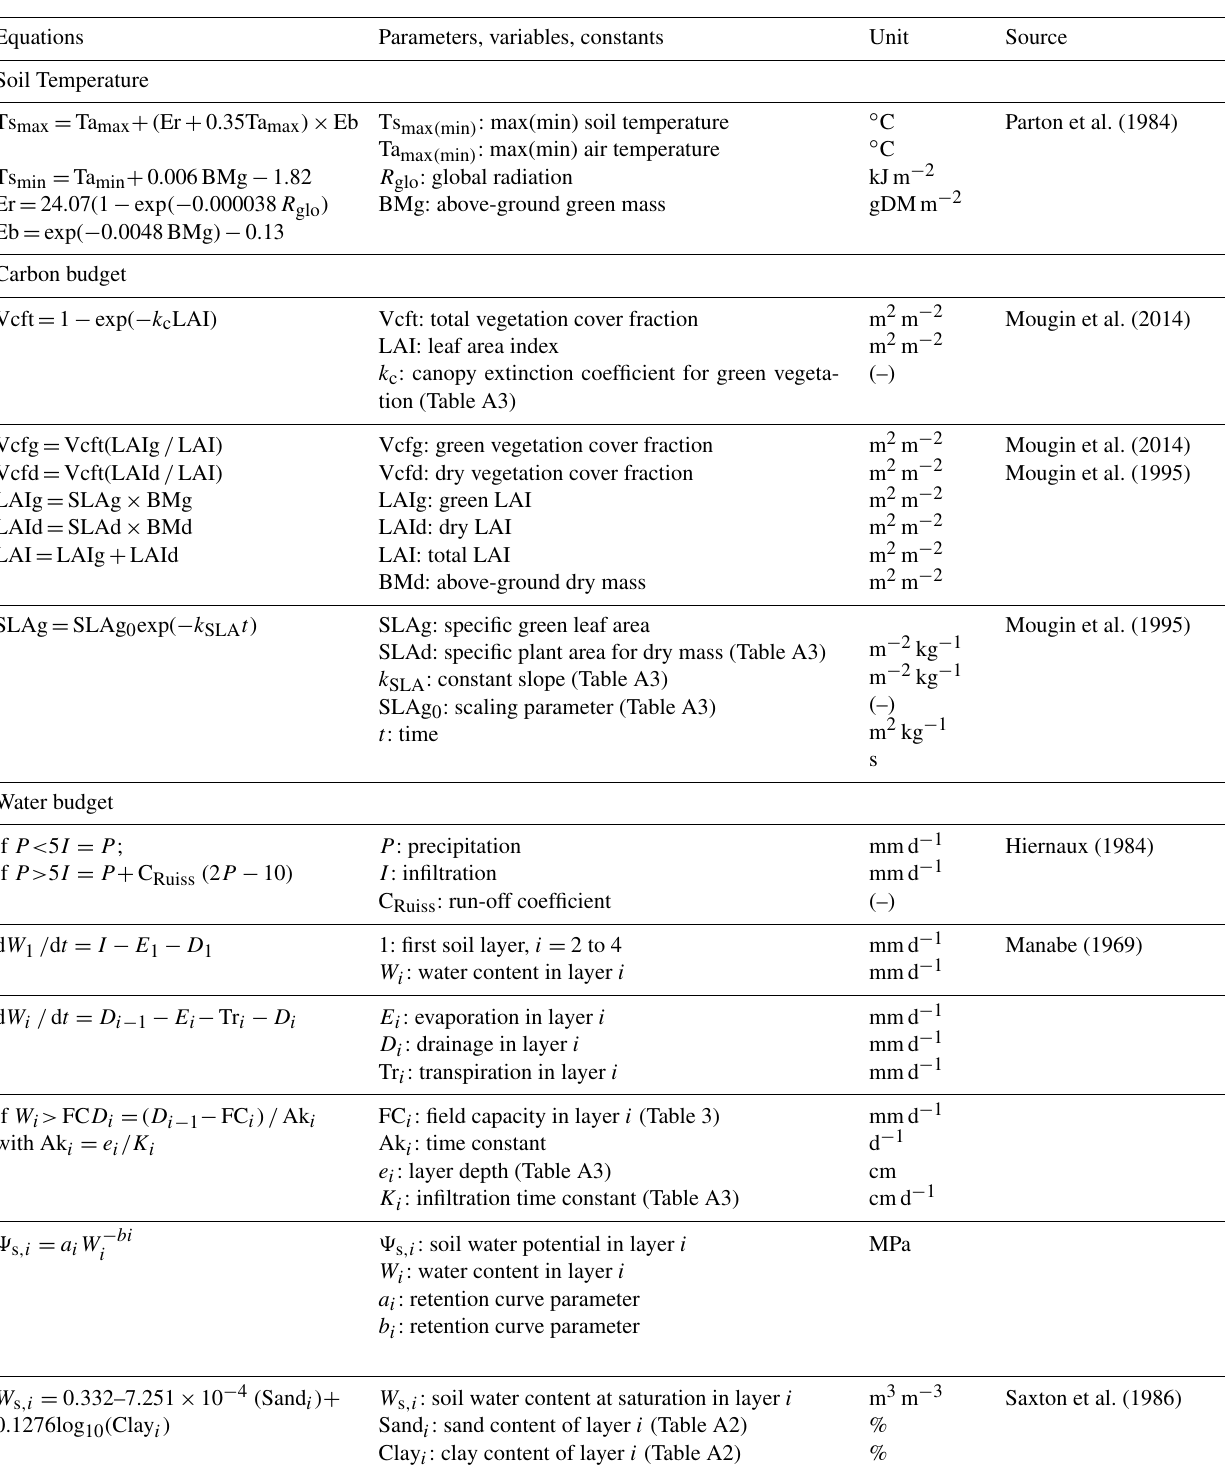
Table A4. Equations, variables, parameters, and constants used in STEP. Variables are in italics. DM: dry